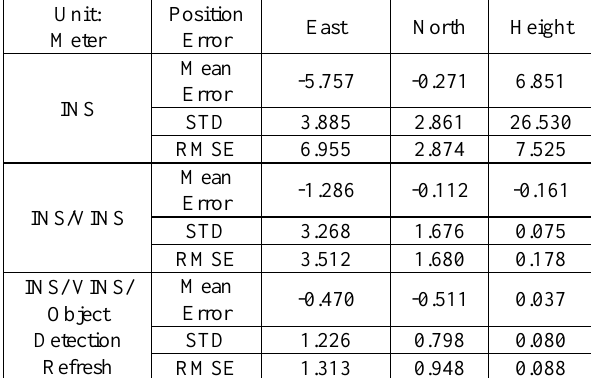
Table 1 . The analysis of the positioning error, including INS, VINS, and proposed integration